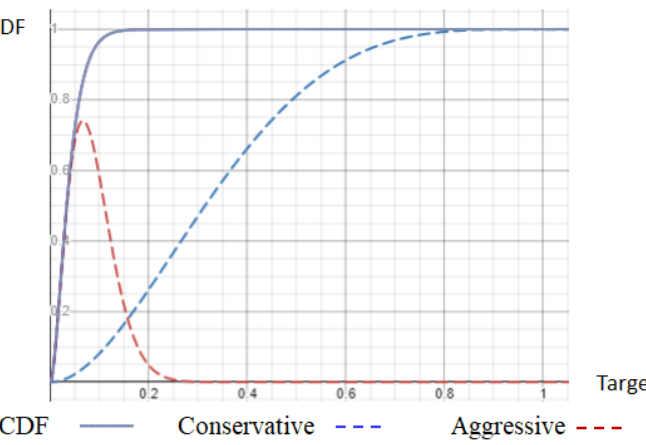
( i − 1 ) u m ( 1 − u ) i − m , and aggressive GPoW, i = m m − 1 ( i − 1 ) u m ( 1 − u ) i − m m − 1 i = m